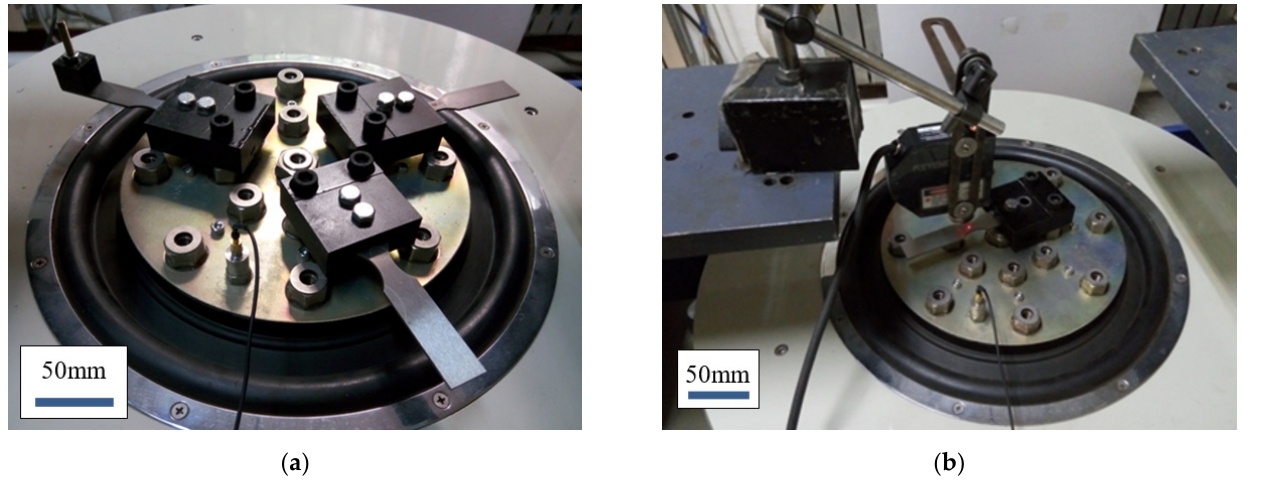
Figure 4. Vibration fatigue test of KMN. ( a ) Vibration test bench; ( b ) laser displacement sensor. The RitecSNAP high-energy ultrasonic system was used to perform ultrasonic Lamb wave nonlinear measurements on KMN specimens with different fatigue damage, as